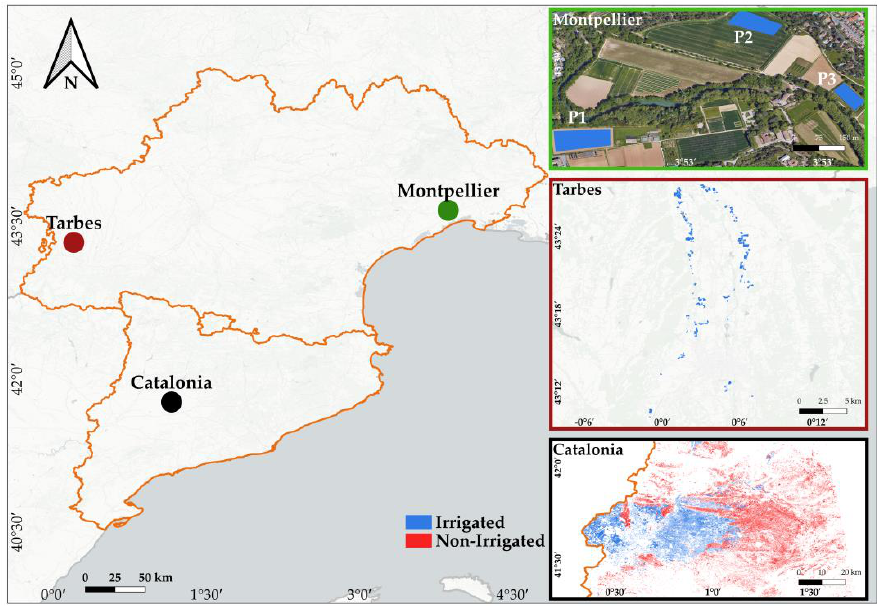
Figure 1. Location of the three studied sites. In green, Montpellier of southeast France; in black, Catalonia region in northeast Spain; and in red, Tarbes of southwest France. Irrigated plots are presented in blue while non-irrigated plots are in red.